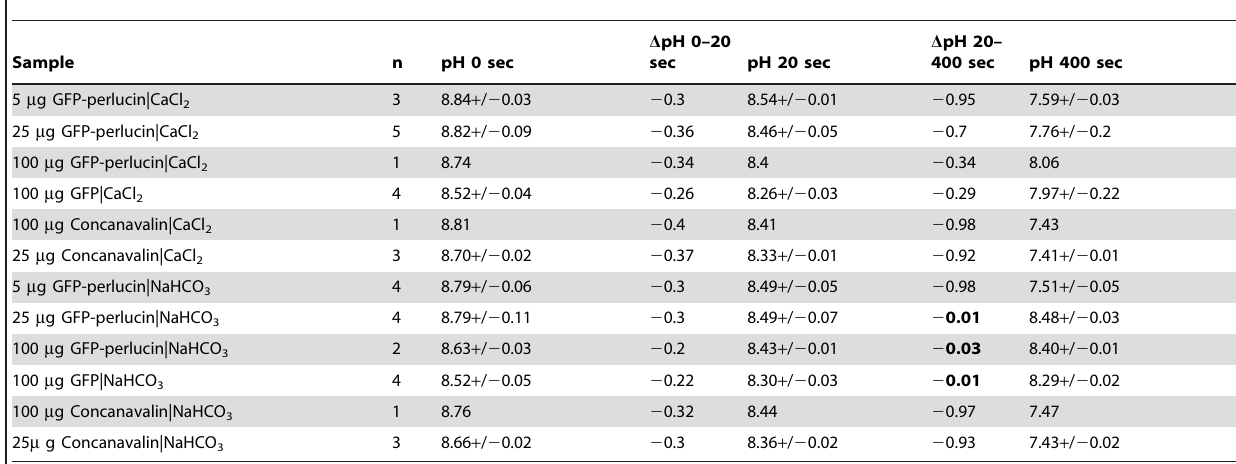
Table 2. Calcium carbonate precipitation: Effect of protein additives and concentrations.